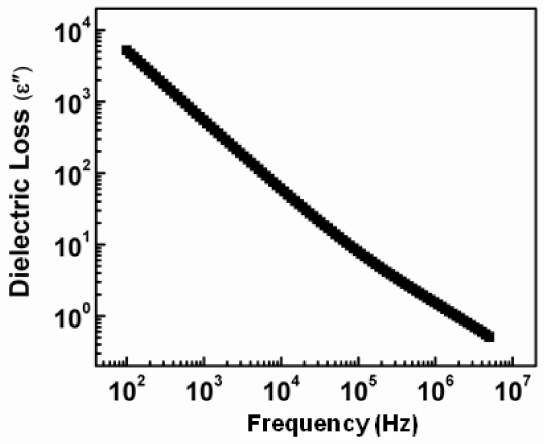
Figure 6. Dielectric loss variation of synthesized NiS along with a change in